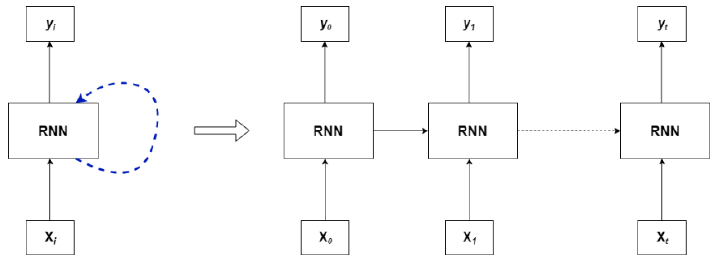
Figure 1. Recurrent neural network .